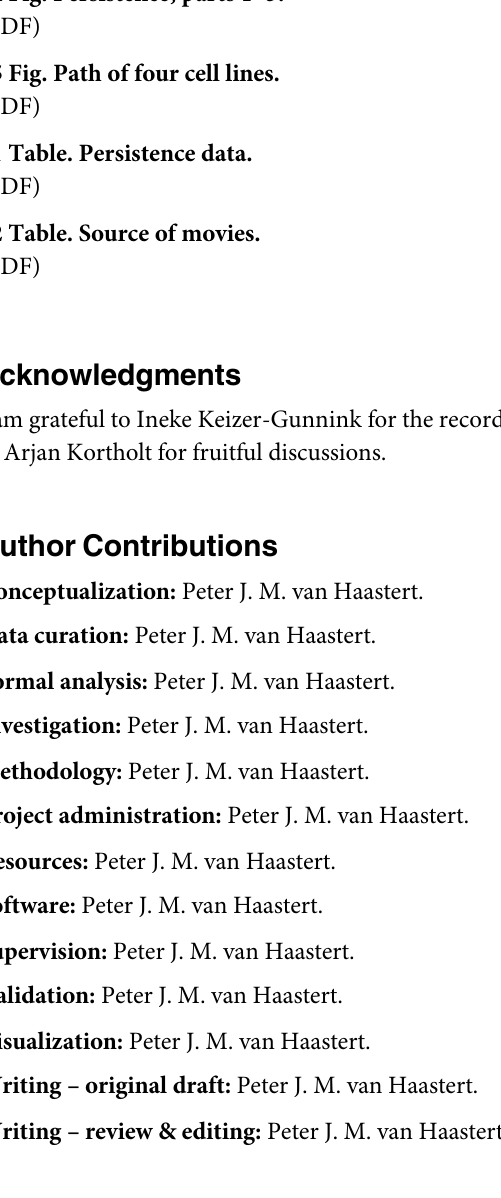
S1 Fig. Kinetics of positional memory, defined by %LR. (PDF) S2 Fig. The kinetics of turning in buffer and in a chemotactic gradient. (PDF) S3 Fig. Polarized cells without positional memory have a small alternating L/R bias. (PDF) S4 Fig. Persistence; parts 1–3. S5 Fig. Path of four cell lines. (PDF) S1 Table. Persistence data. (PDF) S2 Table. Source of movies.